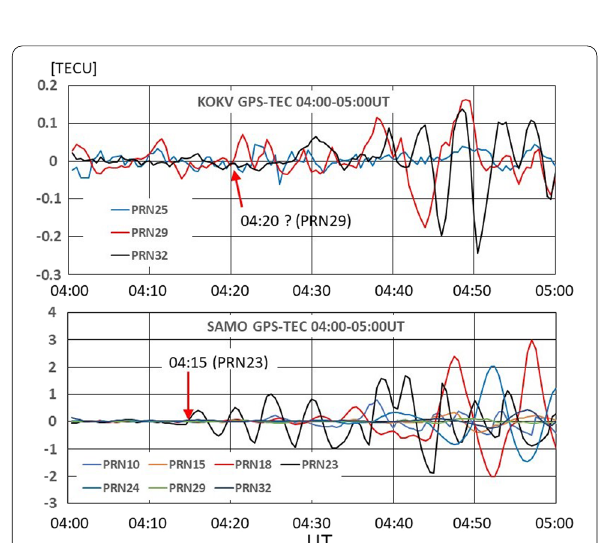
Fig. 5 Enlarged plots of the TEC variations. The upper panel shows the high-pass filtered TEC data plots for 3 GPS satellites and the lower panel shows the plots for 7 GPS satellites. A wavy variation starts at 04:15 UT at SAMO and a similar but with much smaller amplitude variation start at 04:20 UT at KOKV station. Note that the scale for KOKV and SAMO is different